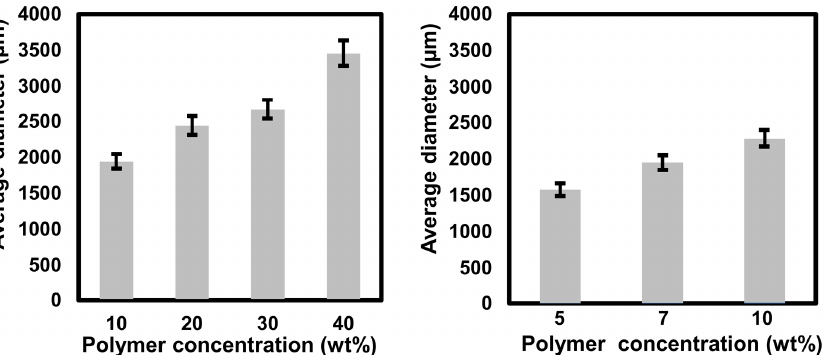
Figure 4. Particle diameter of polystyrene microsphere particles synthesized at different ( a ) polymer concentrations and ( b ) surfactant concentrations under continuous stirring rate at 1500 rpm at 80 °C (error bars shows standard deviation).